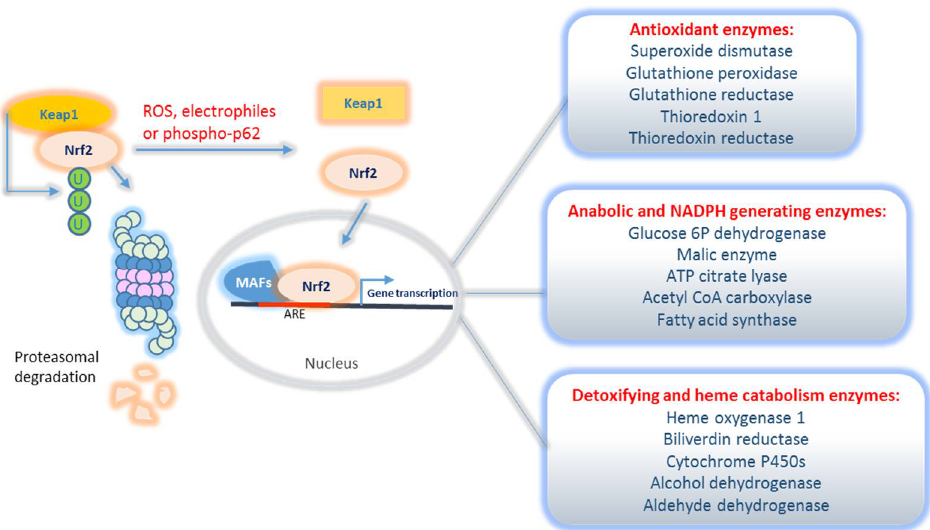
Figure 2. Molecular targets and pathways regulated by Nrf2. Under normal conditions, Keap1 binds to Nrf2 and promotes its ubiquitination and proteasome-mediated degradation. Under electrophilic or oxidative stress conditions, Keap1 undergoes a conformational change that decreases affinity to Nrf2. Consequently, Nrf2 is released and translocates to the nucleus, where it stimulates the transcription of a battery of genes including antioxidant, detoxifying and anabolic ones.